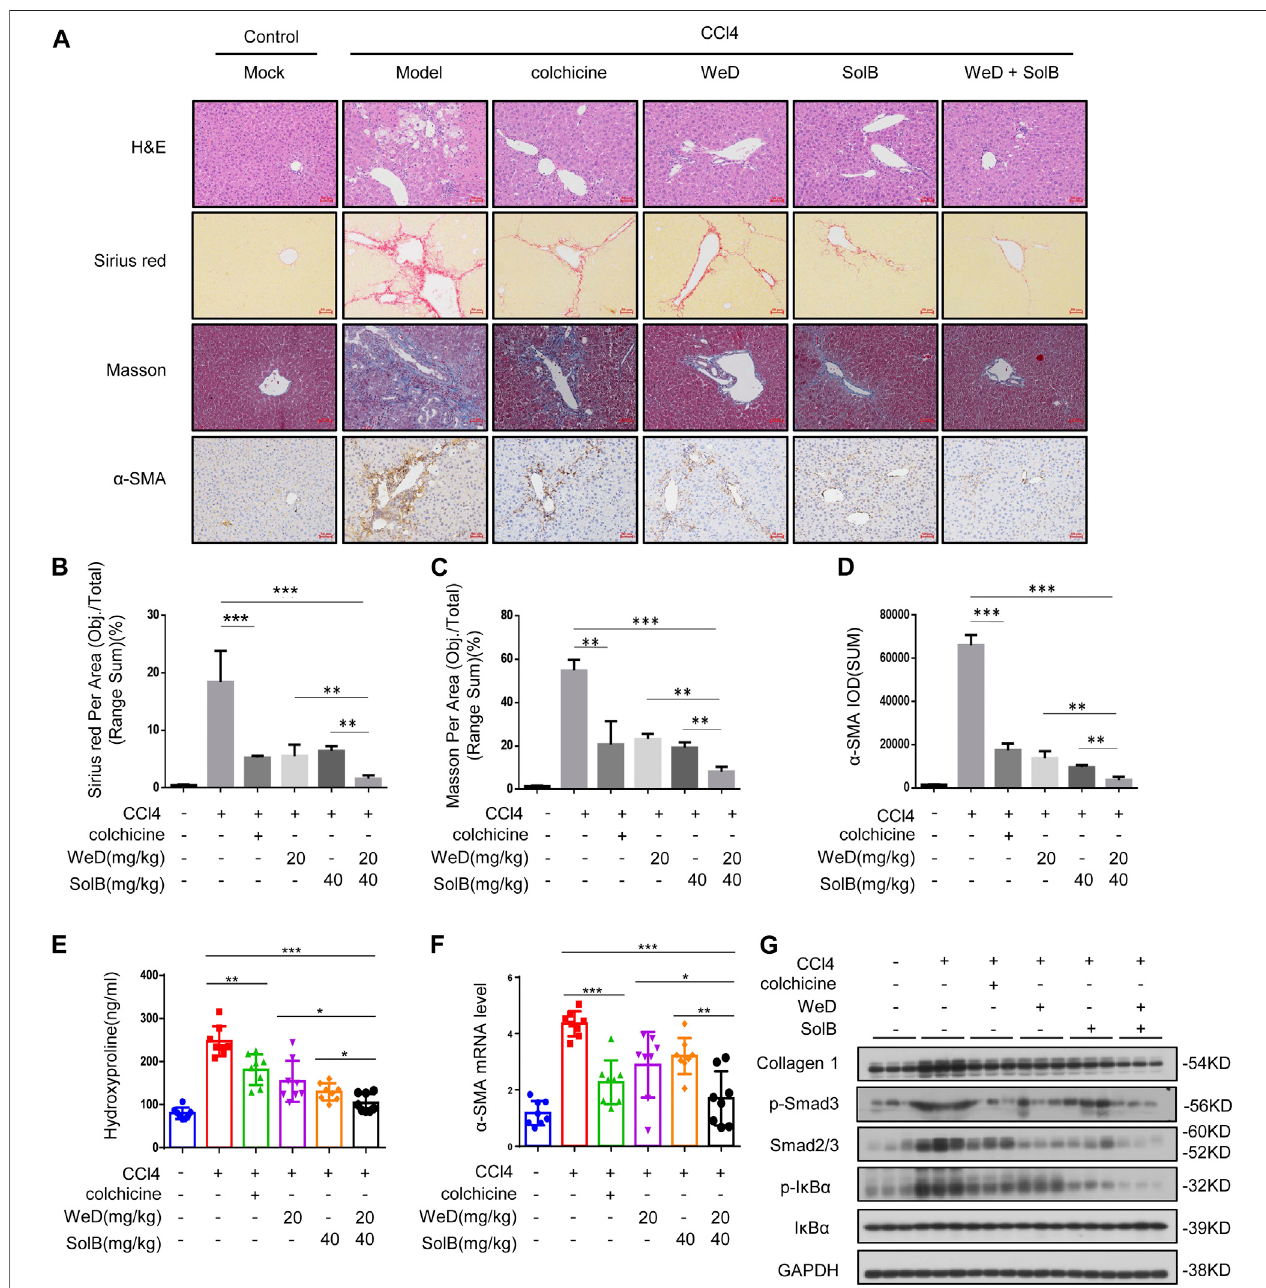
FIGURE 5 | A combination of SolB and WeD treatment dramatically inhibits hepatic fi brosis and injury in CCL4-induced hepatic fi brosis mice (A) Images of livers from control, CCL4-induced hepatic fi brosis mice, CCL4-induced hepatic fi brosis mice treated with colchicine (0.2 mg/kg), SolB (40 mg/kg), WeD (20 mg/kg) or combinationofSolB(40 mg/kg)andWeD(20 mg/kg).RepresentativemicrographsofliverH&Estaining,Siriusred,Masson,and α -SMAstainingwereshown.Scalebars represent 50 μ m (B – D) Quantitative results of Sirius red (B) , Masson (C) , and α -SMA (D) staining sections (E) Serum level of hydroxyproline of control, CCL4- induced hepatic fi brosis mice, CCL4-induced hepatic fi brosis mice treated with colchicine (0.2 mg/kg), SolB (40 mg/kg), WeD (20 mg/kg) or combination of SolB and WeD (F) QuantitativePCRanalysisofmRNAlevelsof α -SMAinliversfromcontrol,CCL4-inducedhepatic fi brosismice,CCL4-induced hepatic fi brosismicetreatedwith colchicine (0.2 mg/kg), SolB (40 mg/kg), WeD (20 mg/kg) or combination of SolB and WeD. (G) Western blot analysis of Collagen1, p -Smad3, Smad2/3, p -I κ B α , I κ B α and GAPDH in livers from control, CCL4-induced hepatic fi brosis mice, CCL4-induced hepatic fi brosis mice treated with colchicine (0.2 mg/kg), SolB (40 mg/kg), WeD (20 mg/kg) or combination of SolB and WeD. Data are expressed as Mean ± SD ( n (cid:2) 8 or 3 mice). Statistics differences were analyzed using One-way ANOVA followed by Tukey ’ s post hoc test: * p < 0.05, ** p < 0.01, *** p < 0.001. NS, no signi fi cance.